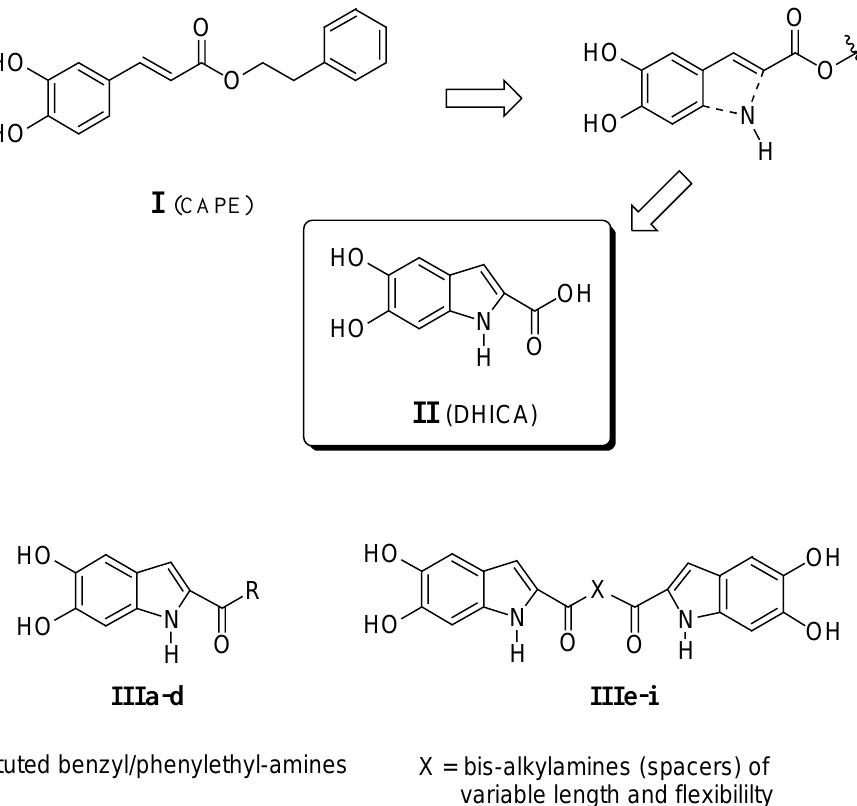
Figure 1 . Design of DHICA from CAPE and DHICA derivatives.